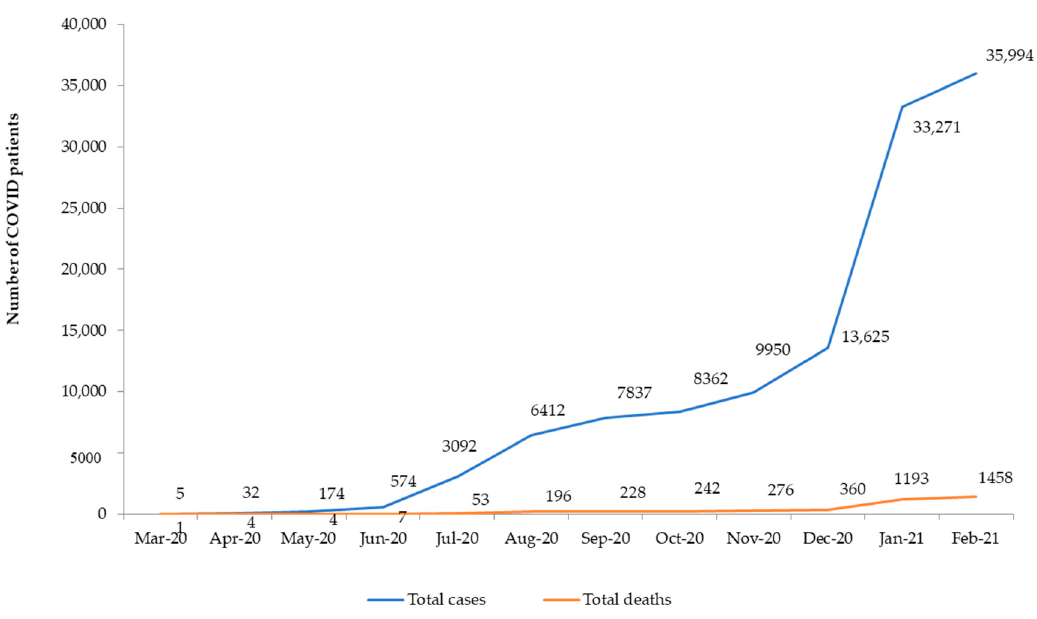
Figure 1. Cumulative number of COVID-19 cases and deaths in Zimbabwe between March 2020 and February 2021 as reported to the World Health Organization.